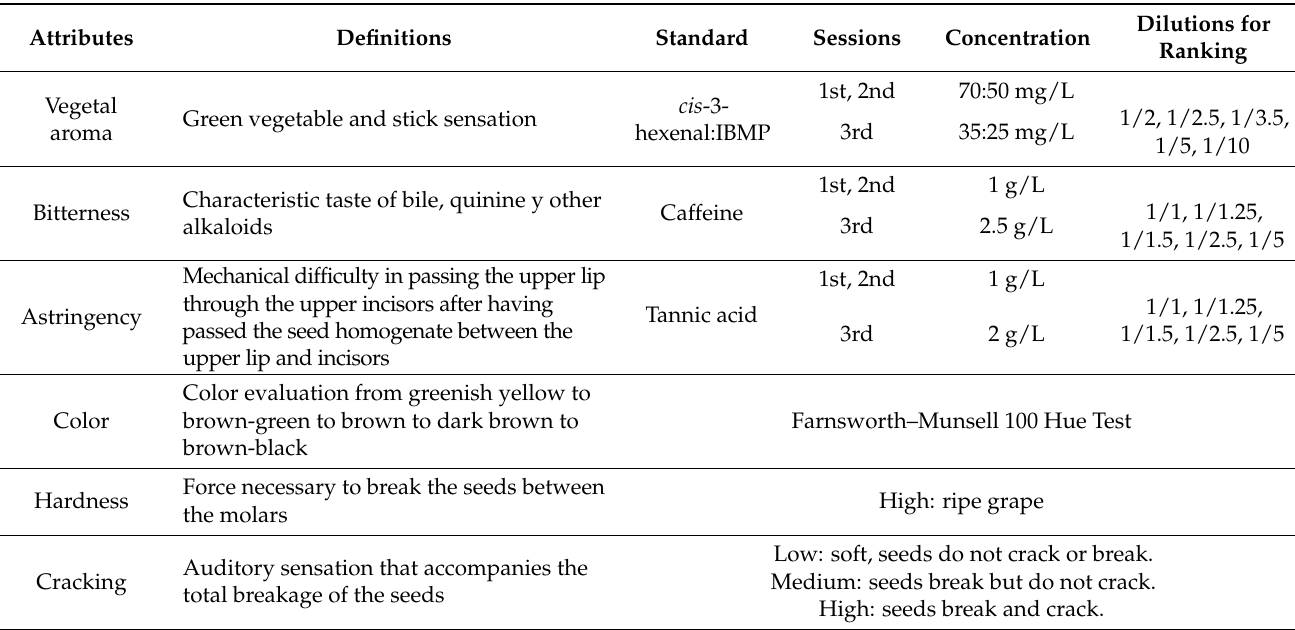
Table 3. Descriptors used for sensory evaluation of grape seeds 1